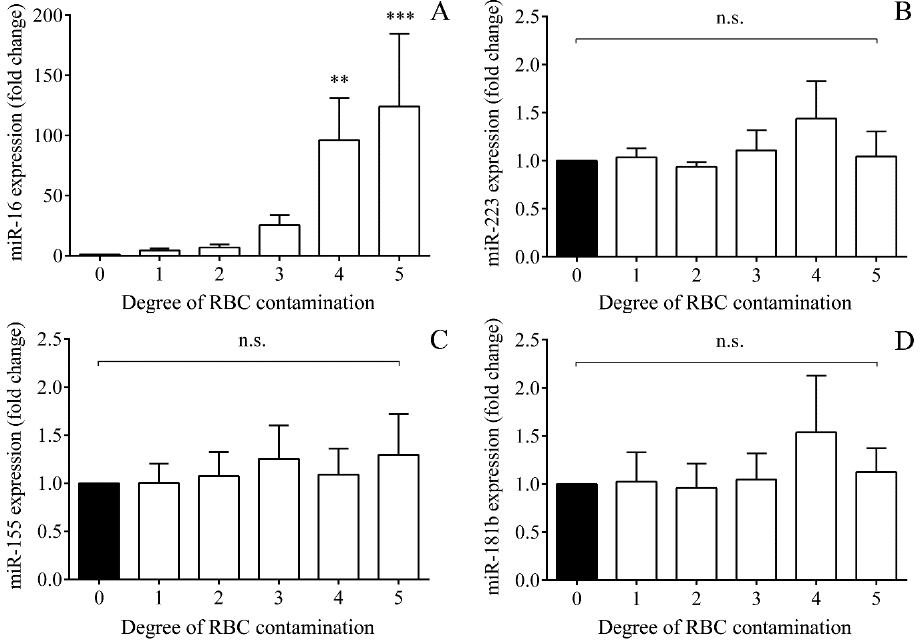
Figure 6. In vitro controlled hemolysis experiments ( n = 5 / condition) were performed to investigate whether these miRNAs were released from RBCs upon IVH. Hemolysis was artificially produced in plasma samples by adding RBCs in di ff erent degree (0, 1, 2.5, 5, 10, and 50% v / v). Artificial hemolysis at di ff erent extents led to the expression of RBC-specific miR-16 in the same tendency ( A ); however, even a massive hemolysis did not influence miR-223 ( B ), miR-155 ( C ), or miR-181b ( D ) levels. Mean ± SEM are depicted. ** p < 0.010, *** p < 0.001, n.s.: Not significant based on Friedman test with Dunn’s multiple comparisons test or ANOVA with Bonferroni’s multiple comparisons test. IVH: Intraventricular hemorrhage, miRNA: MicroRNA, RBC: Red blood